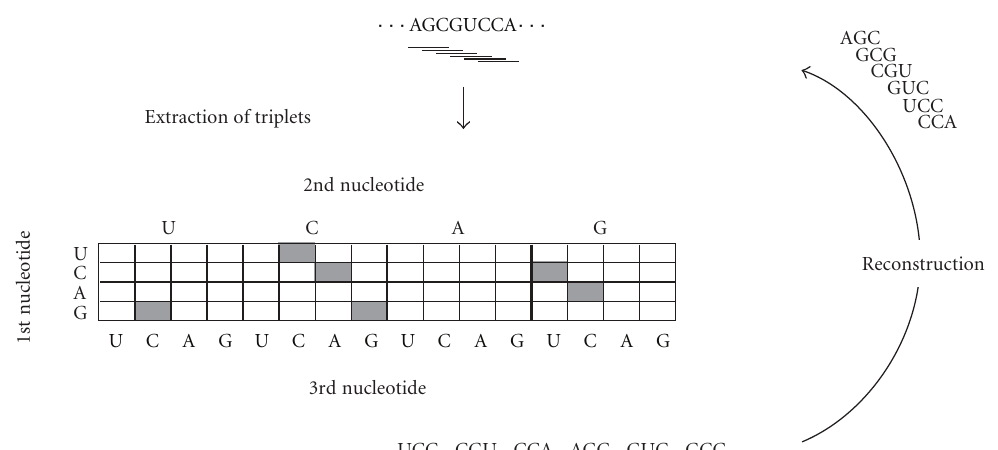
Figure 1: The scheme for the basic triplet analysis of a library. Frequent successive sequences could be determined by this